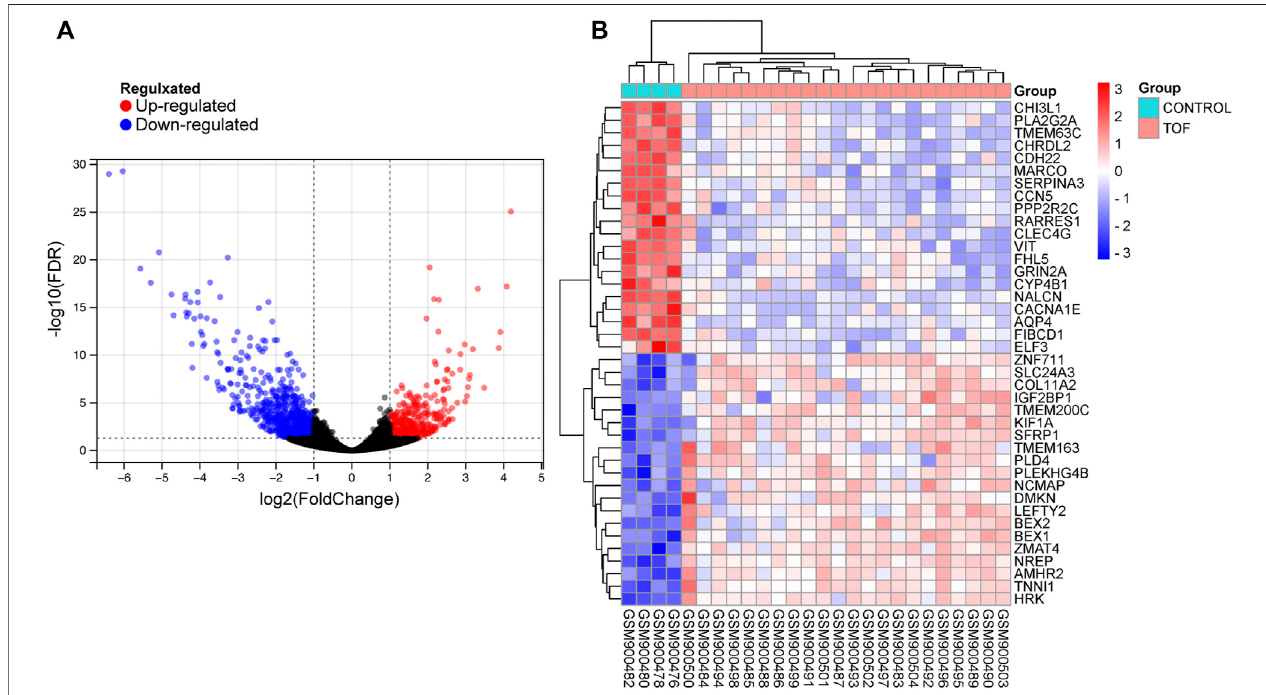
FIGURE 2 | Acquire differentially expressed genes of TOF (DEmRNAs). (A) Volcano plots for DEmRNAs, the red and green points represent up and down expressed DEmRNAs respectively. (B) A heatmap for 40 DEmRNAs we selected, the change in color represents the difference in expression.